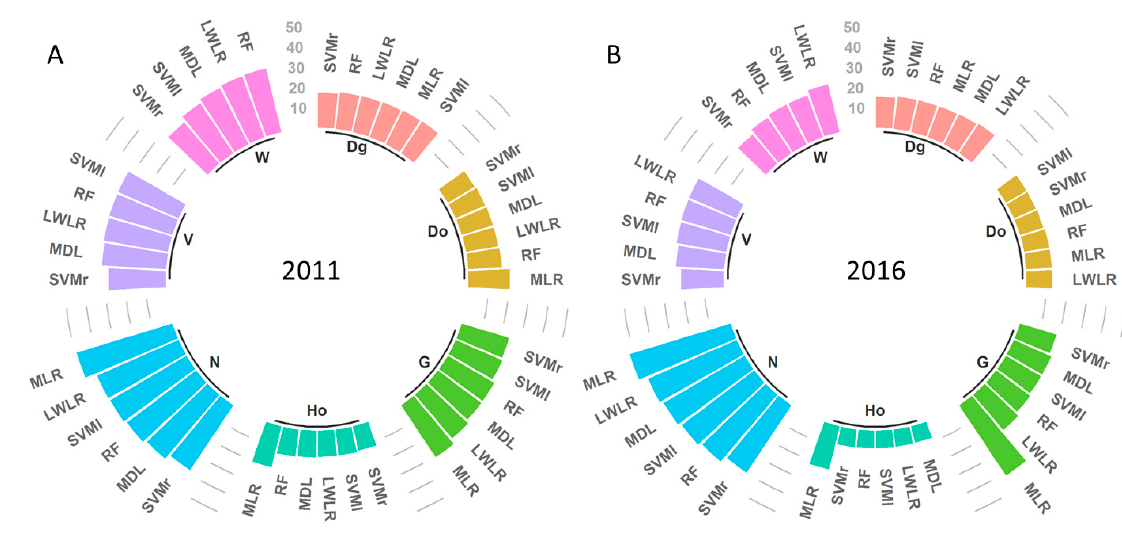
Figure 5. % root mean square error (RMSE) respect to the mean of the different regression methods for estimating the forest inventory attributes for 2011 ( A ) and 2016 ( B ).